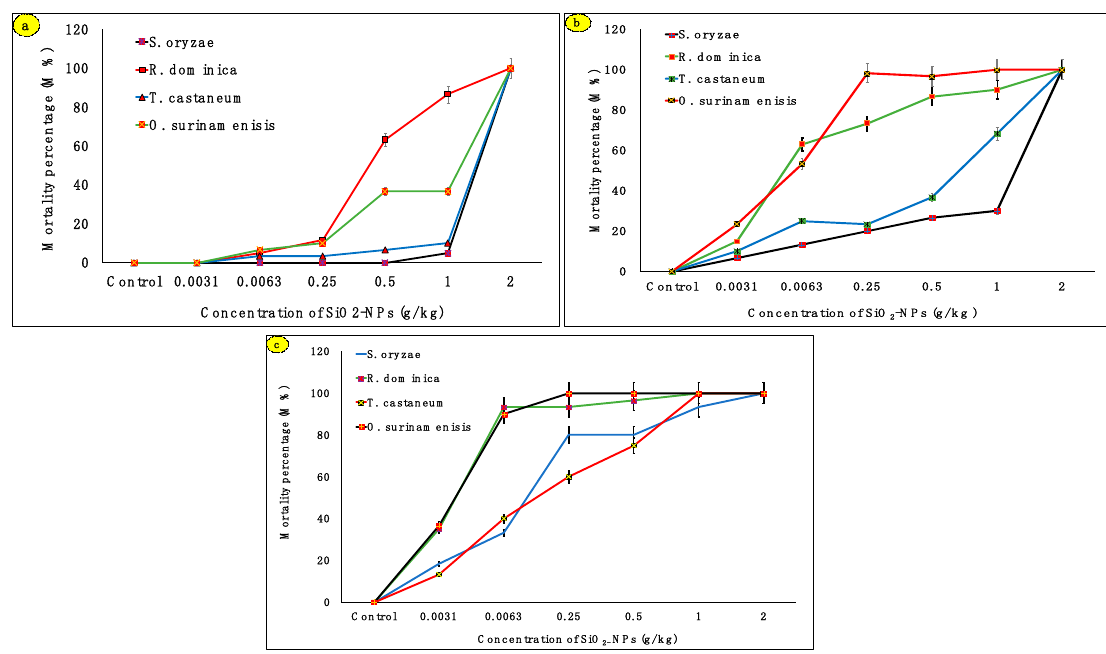
Figure 8. Mortality % of SiO 2 -NPs against S. oryzae , R. dominica , T. castaneum and O. surinamenisis ( a ) after 24 h; ( b ) after 48 h and ( c ) after 72 h.